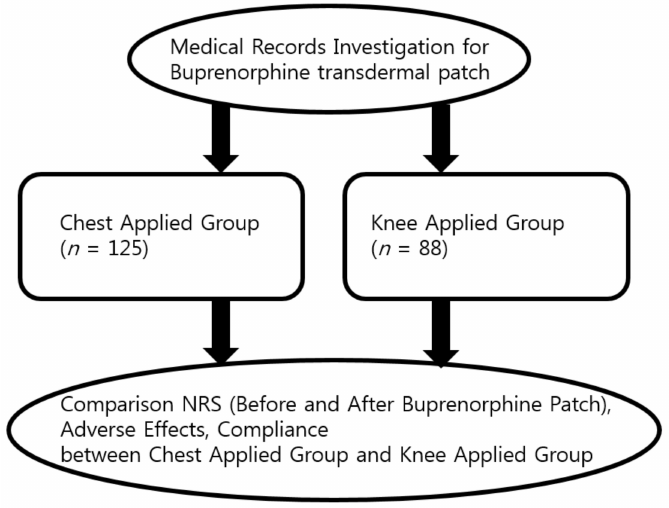
Figure 3. A flow diagram of research. NRS, Numeric Rating